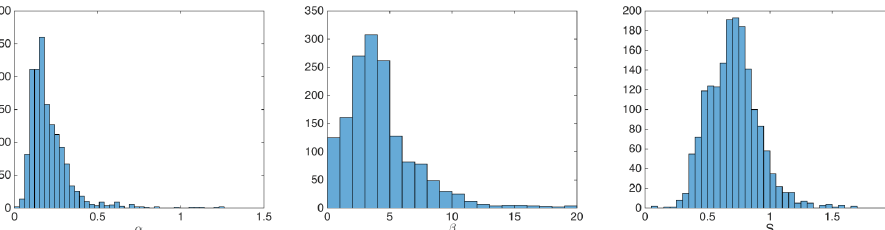
Figure B1. Distribution of α , β and s for FYI. Data of 40m resolution (OIB) are used for computing the value of each parameter on the scale of 37.5km (i.e., approximately the native resolution of SMOS TB).